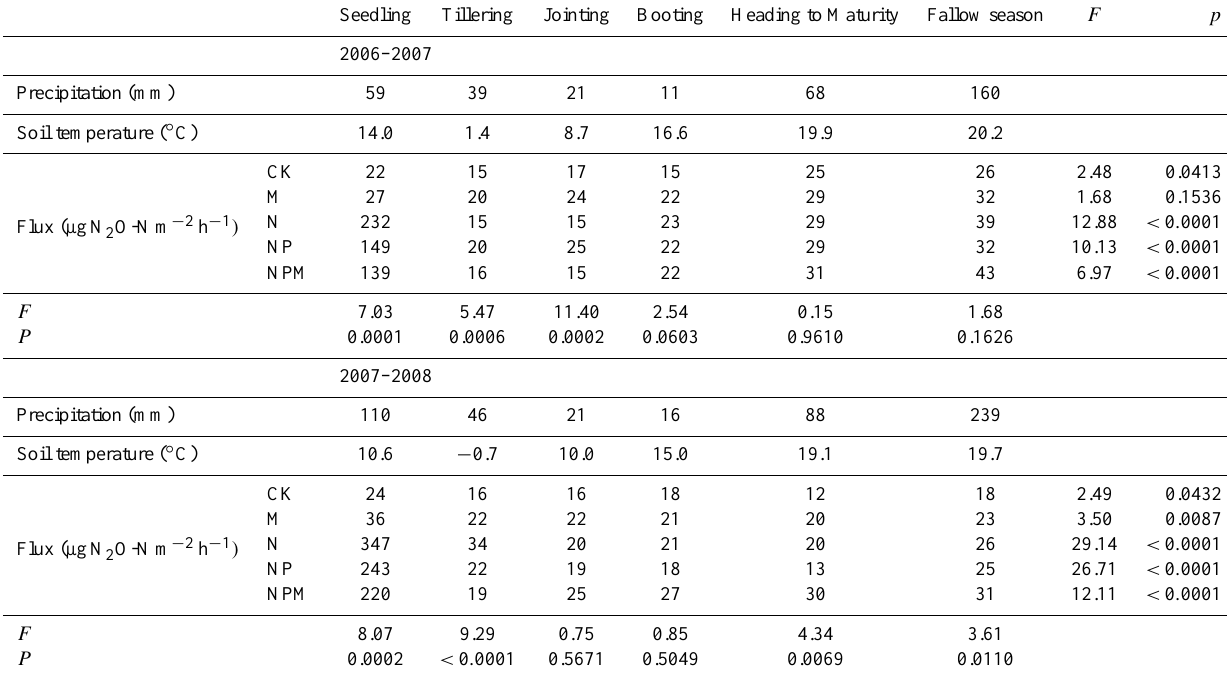
Table 3. N 2 O fluxes in growing seasons and fallow season as affected by fertilization. Seedling Tillering Jointing Booting Heading to